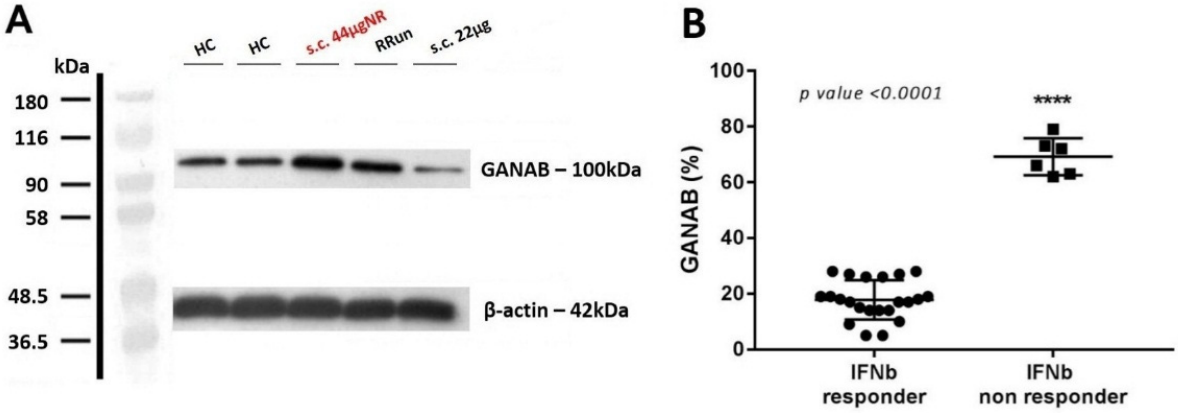
Figure 4. GANAB in the IFNbeta responder and non-responder patients. ( A ) Representative image of Western blotting for GANAB from one non-responder patient that received s.c. 44 µ g of IFNbeta-1a formulation (s.c. 44 µ gNR) (red). GANAB expression is represented for healthy controls (HCs), for one untreated relapsing remitting patient (RRun), and finally from a responder IFN-treated patient who underwent the s.c. 22 µ g formulation (s.c. 22 µ g). Note the upregulation of GANAB in the non-responder as well in the untreated patient compared to the responder. ( B ) Comparison of the mean expression of GANAB (%) between the responder and non-responder IFN groups.